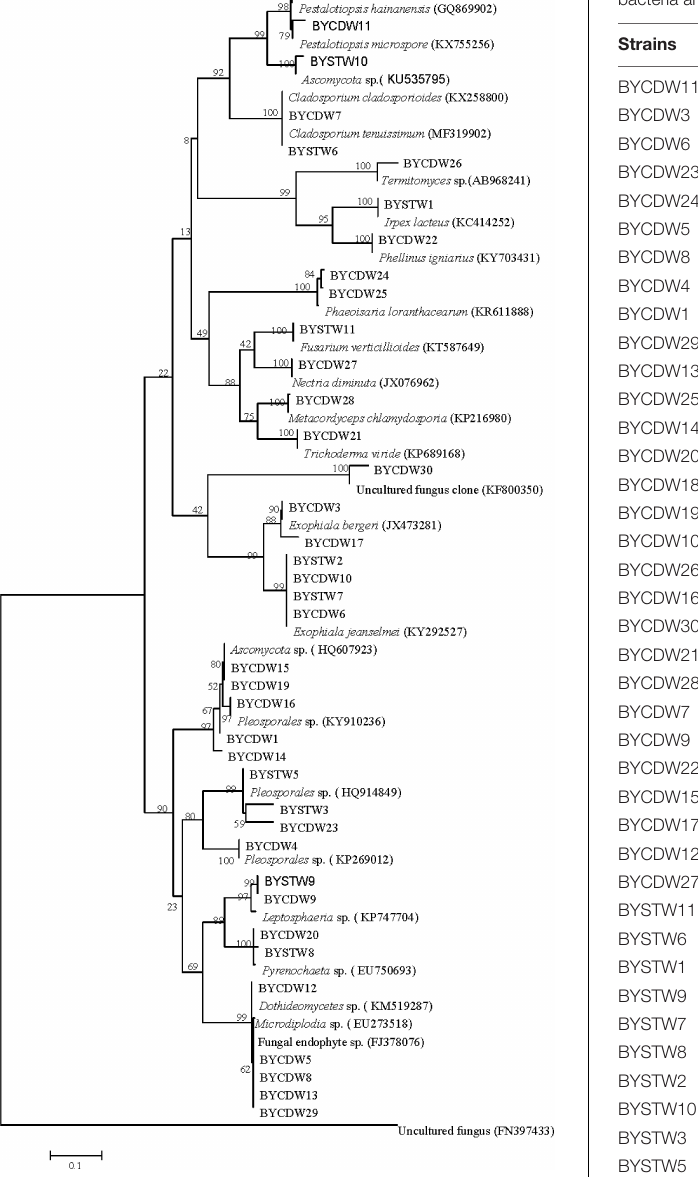
TABLE 2 | Antimicrobial activities of 39 fungal crude extracts against pathogenic bacteria and yeast